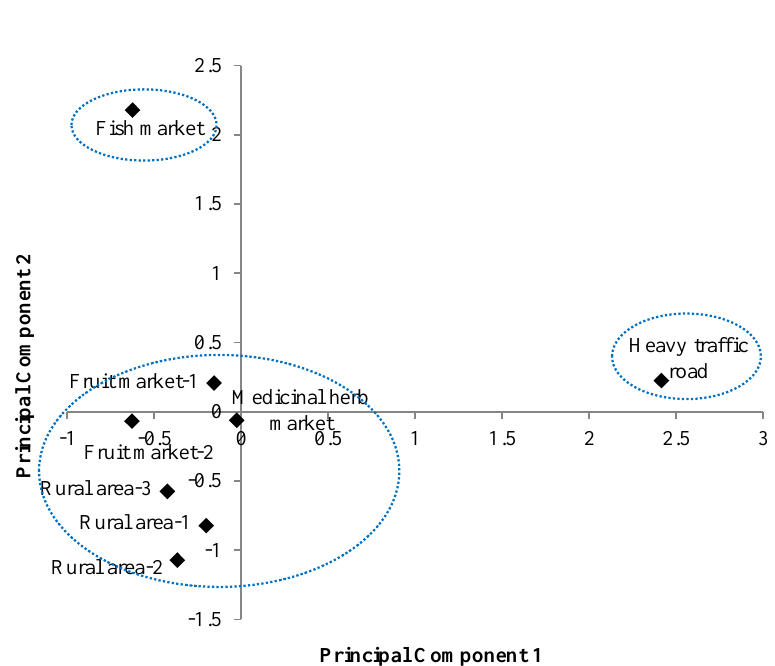
Figure 4. Principal component score plot of the street dust in the projection of principal components 1 and 2.